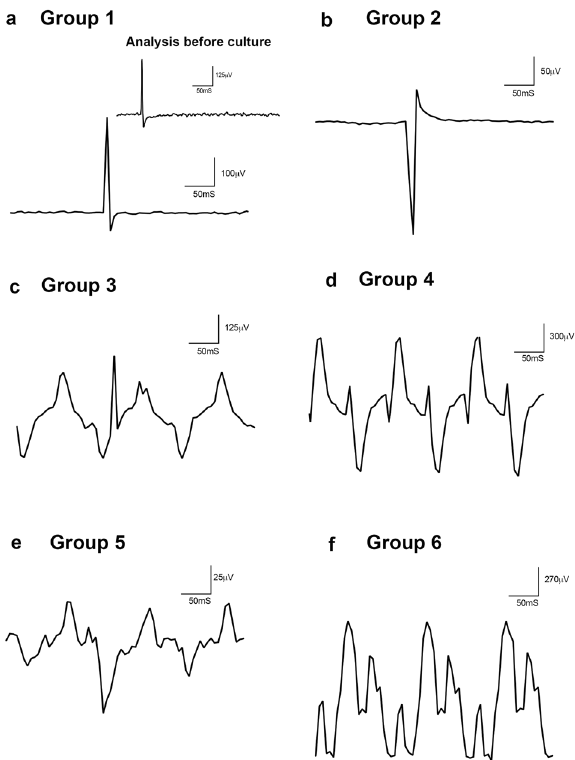
Fig. 10 Increased retinal dysfunction with high IOP and tortuous ON conditions. Full fi eld fl ash ERG recordings on retinas after 14 days perfusion culture. The amplitudes of scotopic threshold responses were measured from the baseline to the positive peak of each waveform and latency measured by time-to-peak major positive de fl ection for ( a ) Group 1, inset- analysis before culture of a fresh postmortem human retina, ( b ) Group 2, ( c ) Group 3, ( d ) Group 4, ( e ) Group 5 and ( f ) Group 6 from 0.3 mcd.s/m 2 to 1000 mcd.s/m 2